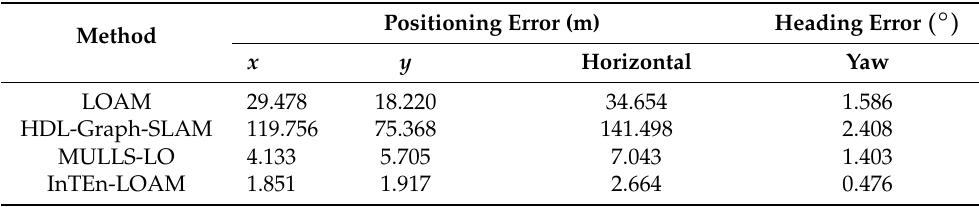
Figure 13. Constructed points maps with details and estimated trajectories. ( a , c , e ) maps of Seq.00, 01 and 05; ( b , d , f ) trajectories of Seq.00, 01 and 05 (groundtruths and InTEn-LOAM). Table 2. Quantitative evaluation and comparison on autonomous driving field